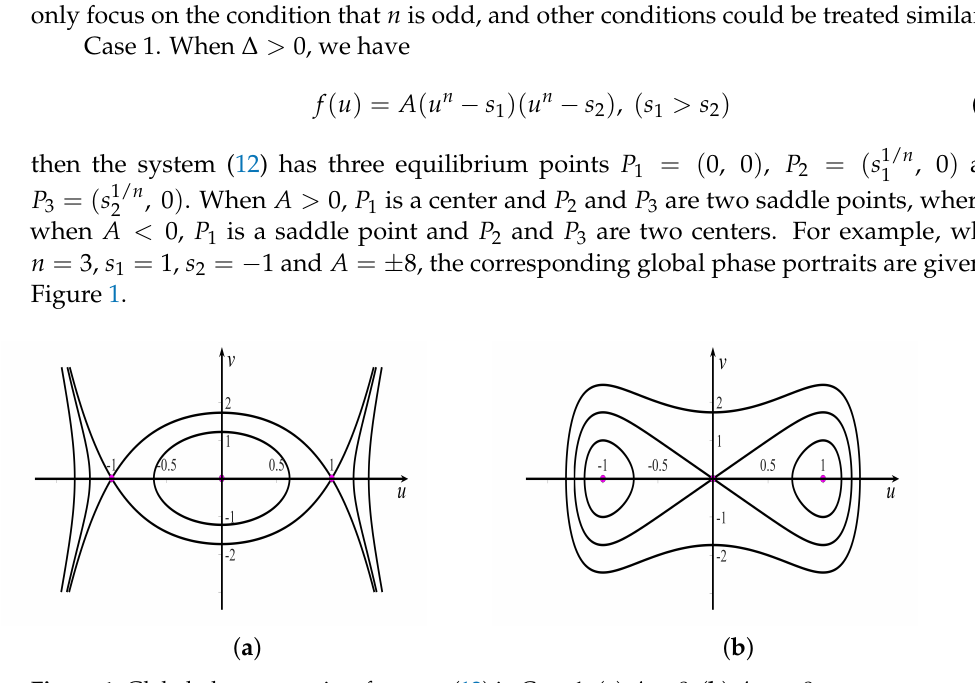
Figure 1. Global phase portraits of system (12) in Case 1: ( a ) A = 8; ( b ) A = −